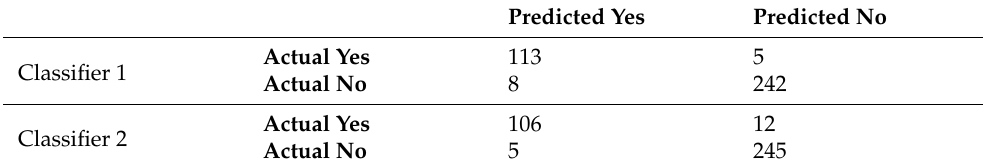
Table 6. Confusion matrix for both fuzzy